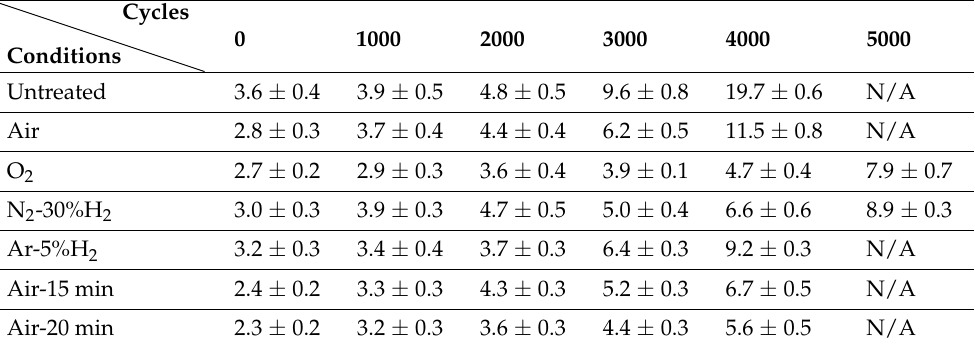
Table 1. Electrical resistivity of the sintered structure on various PI substrates subjected to different bending cycles.